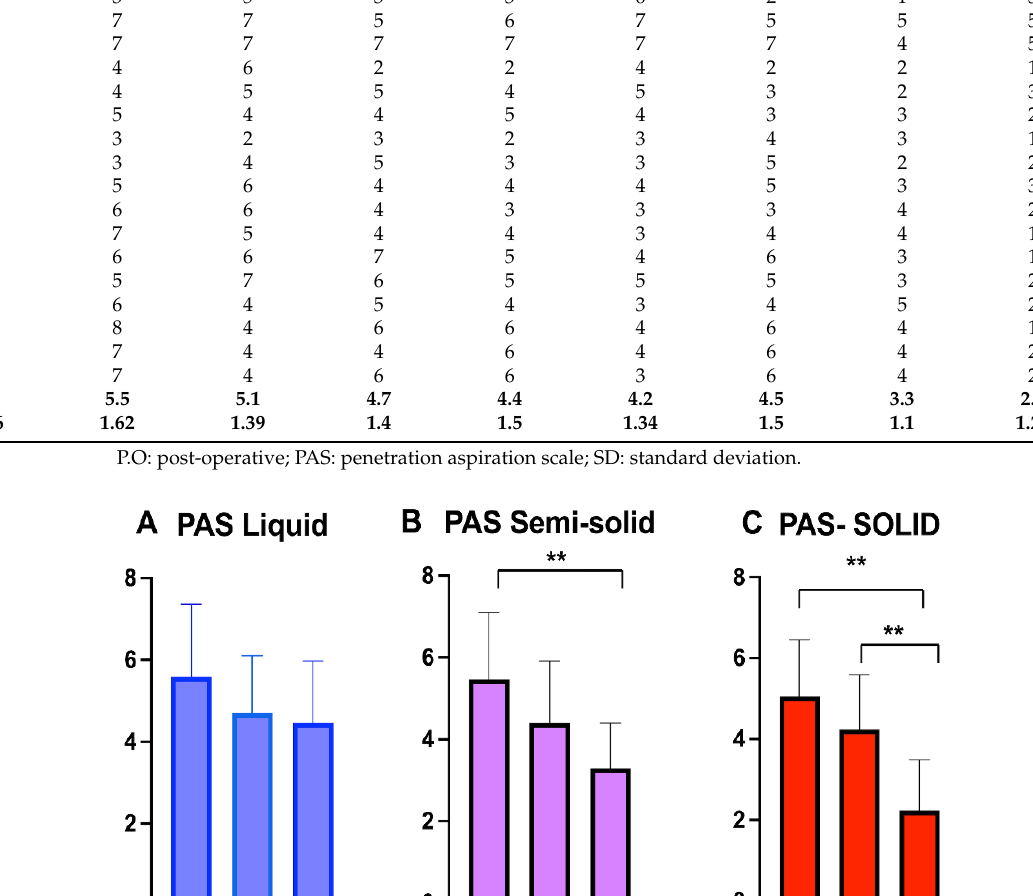
Table 4. Phonation outcomes evaluated by VHI-10 of each patient.